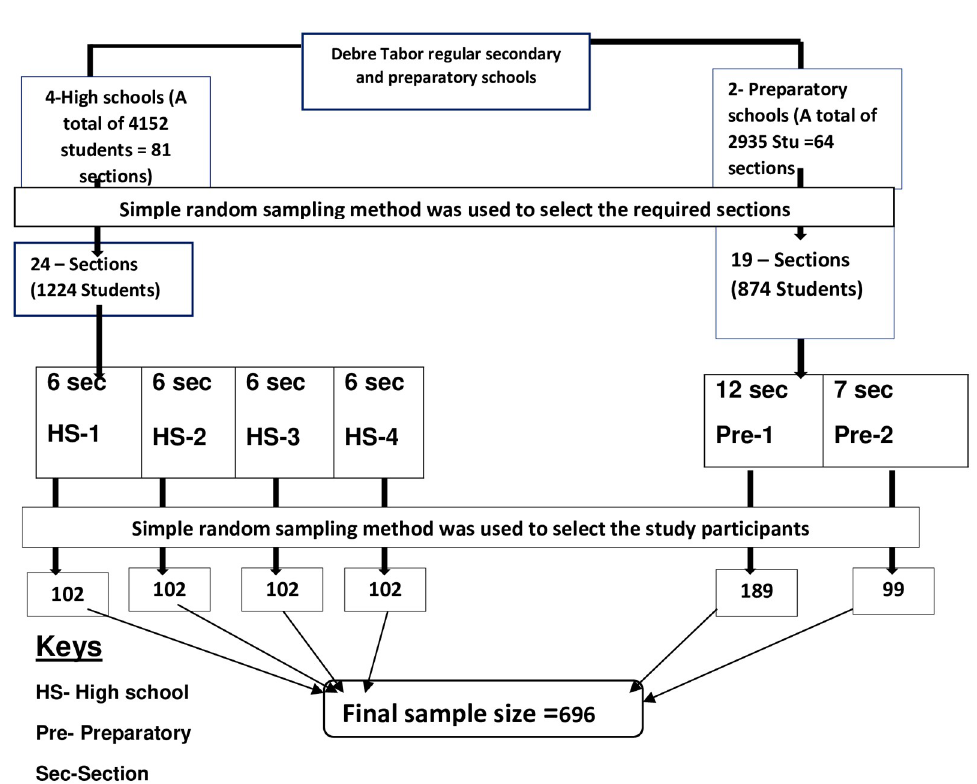
Fig 1. Schematic presentation of sampling